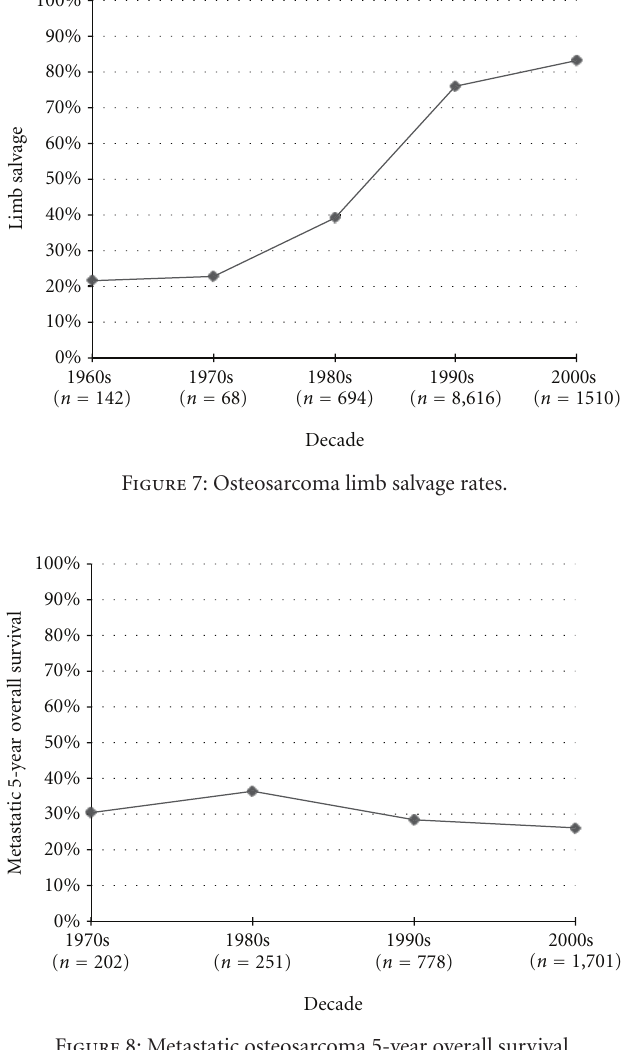
Figure 8: Metastatic osteosarcoma 5-year overall survival.